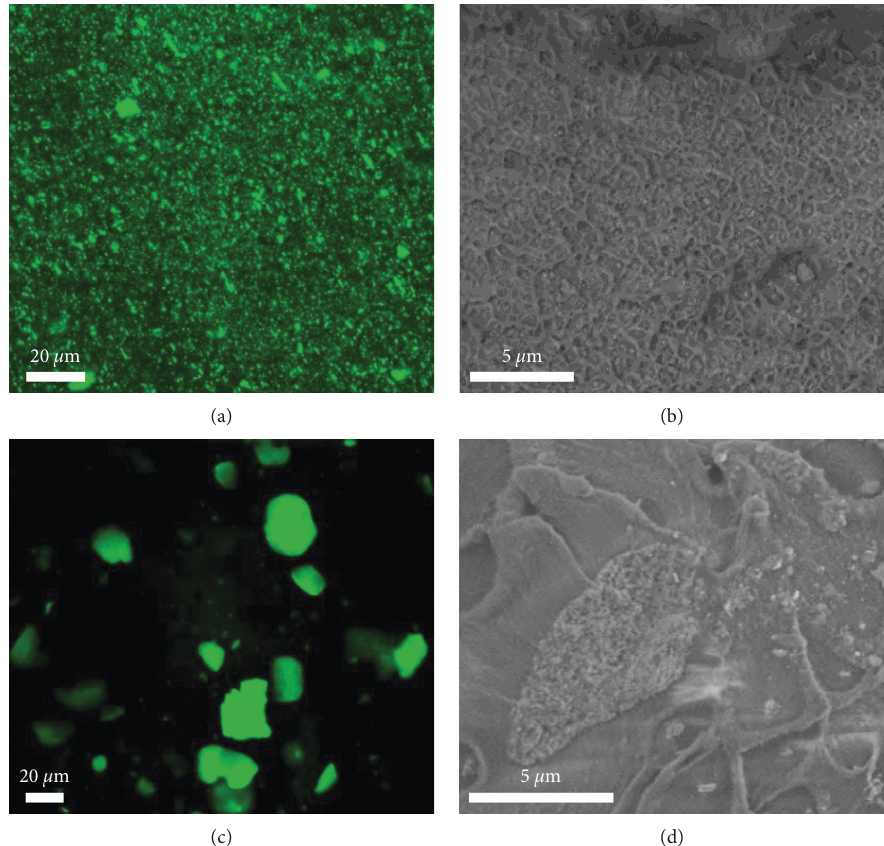
Figure 4: Images of nanocomposites with 10 wt.% alumina prepared by jet milling ((a) LSCM; (b) FESEM) and nanocomposites with 5 wt.% alumina prepared by extrusion ((c) LSCM; (d) FESEM).